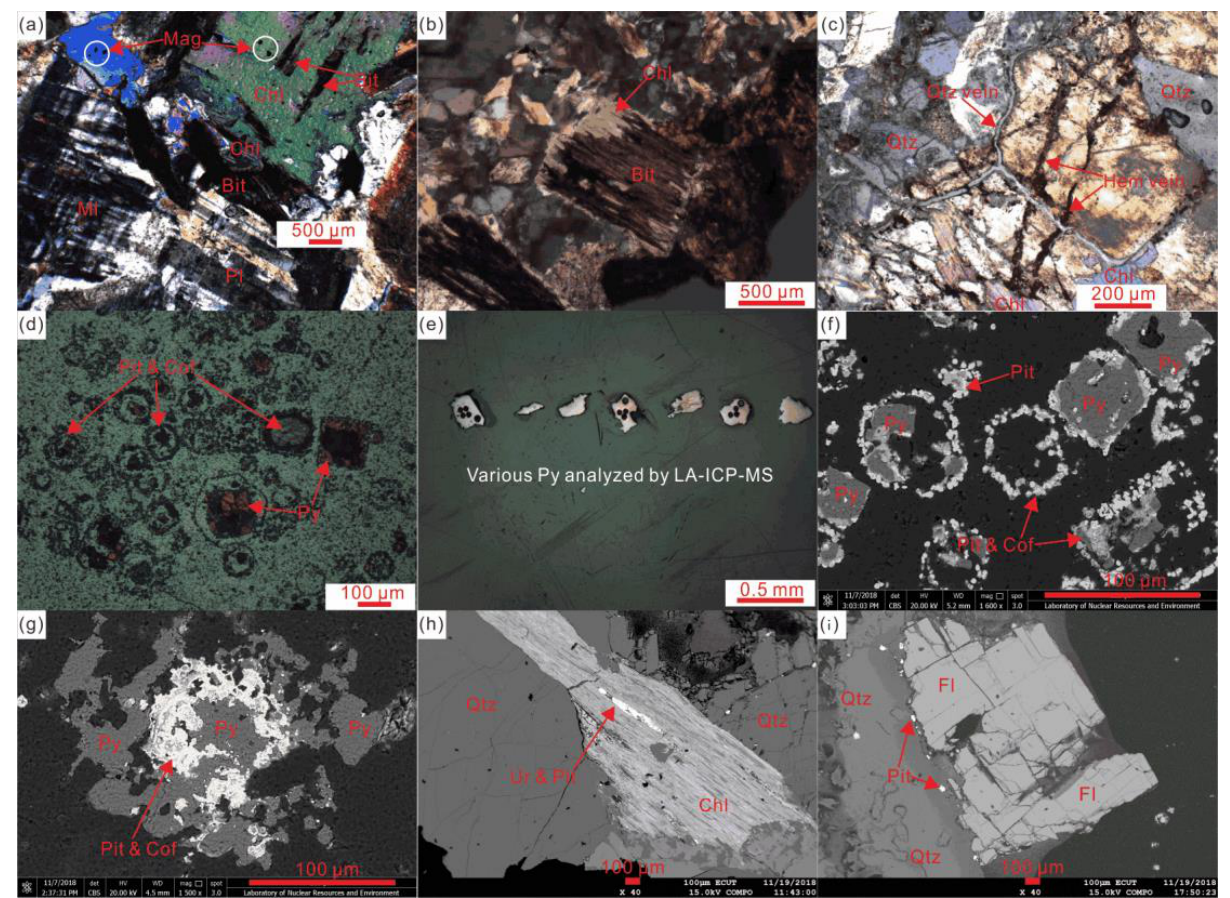
Figure 5. Representative minerals in altered SJOF granites. Notes: Images ( a – e ) are optical mi- crographs; images ( f – i ) are backscatter micrographs. Abbreviations: Bit—biotite; Chl—chlorite; Cof—coffinite; Fl—fluorite; Hem—hematite; Mag—magnetite; Mi—microcline;